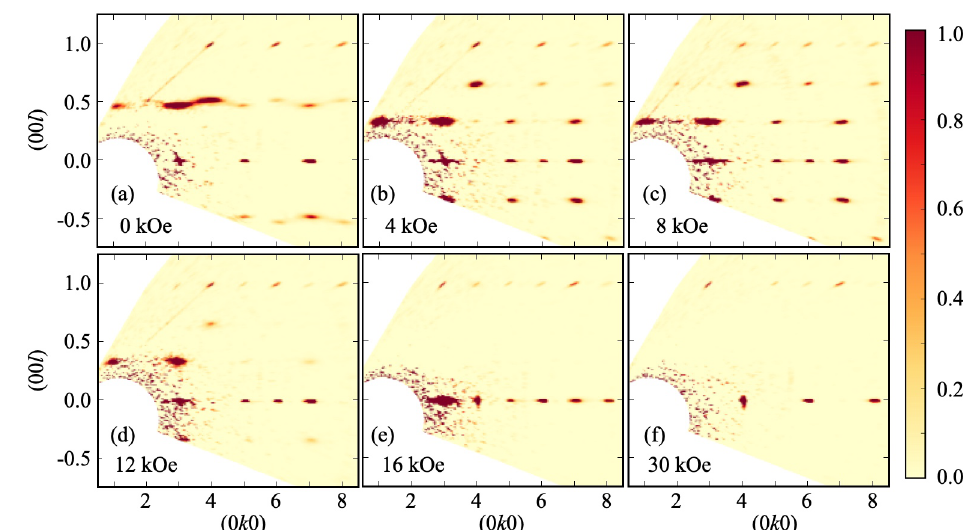
Figure 2: Single crystal neutron diffraction intensity maps of the (0 k l ) plane mea- sured in SrEr O single crystal sample at T = 60 mK in different fields applied parallel 2 4 to the a axis. The high temperature background is subtracted to emphasise the mag- netic contributions. We observe a clear field-evolution of the magnetic state of the Er2 ions from (a) zero-field collection of largely uncorrelated incommensurate spin chains through (b-d) the significantly more correlated UUD structures with q = (0 0 1 ) propagation vector and to (e,f) field-polarised phase characterised by the res- 3 olution limited q = 0 peaks. The antiferromagnetic order formed by the Er1 ions is also seen as a set of ( 0 k l ) peaks with integer k and l peaks present in all fields apart from (f) 30